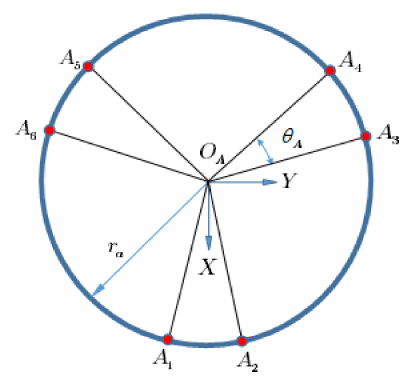
Figure 15. Specifications of the fixed